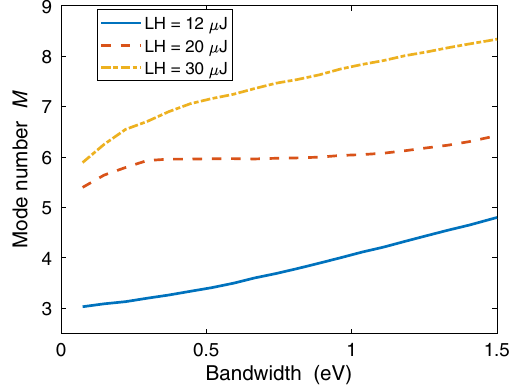
FIG. 15. The effective number of modes M as a function of the integration bandwidth for self-seeding spectral pedestals under different LH energies at U15. The integration bandwidth is offset − 1 . 4 eV from the seed center as measured in the spectra of Fig. 12.